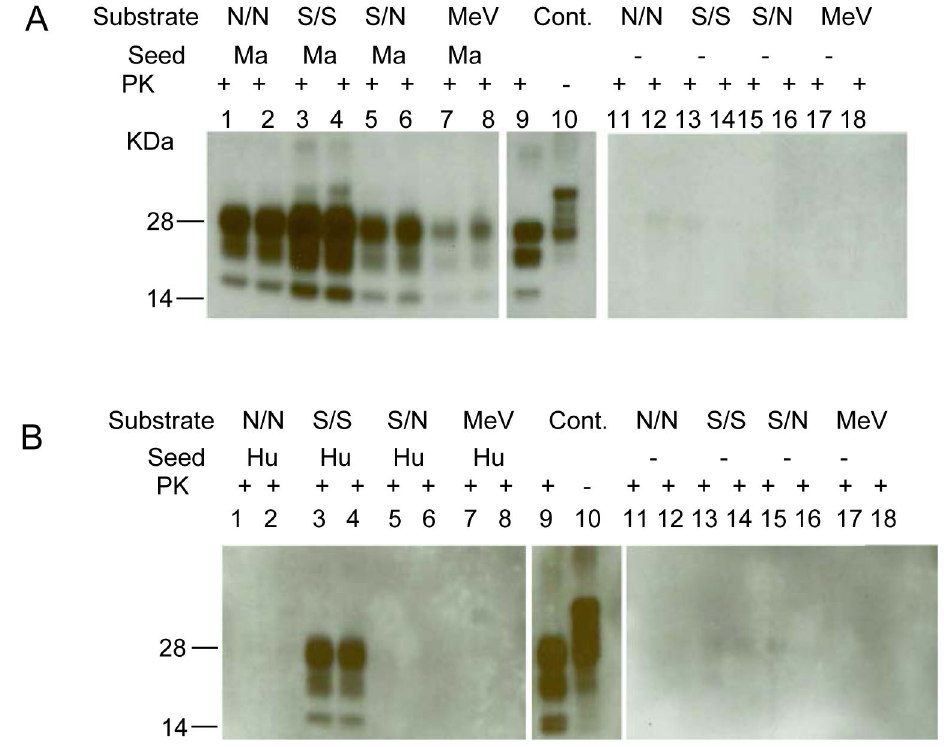
Figure 3. PMCA is affected by the red-backed vole PrP 170 polymorphism. (A) Brain material from macaques clinically ill with vCJD was diluted 10 -3 into 10% RBV 170N/N NBH (lanes 1-2), into 10% RBV 170S/S NBH (lanes 3-4), into 10% RBV 170S/N NBH (lanes 5-6), or into 10% meadow vole (MeV) NBH (lanes 7-8) and subjected to 1 round of PMCA with 3 beads in each. Macaque vCJD brain homogenate (5%) was loaded in lanes 9-10 as positive control (Cont.). Lanes 11-18 indicate 10% RBV 170 (N/N, S/S, S/N respectively), MeV NBH without seed and subjected to 1 round of PMCA. Lanes 1-8 and 11-18 were stained with 6D11 antibody and lanes 9-10 were stained with 3F4 antibody. Prior to electrophoresis, samples were digested with PK. (B) Human vCJD brain material was diluted 10 -3 into 10% RBV 170N/N NBH (lanes 1-2), into 10% RBV 170S/S NBH (lanes 3-4), into 10% RBV 170S/N NBH (lanes 5-6), into 10% meadow vole NBH (lanes 7-8) and subjected to 1 round of PMCA with 3 beads in each. Human vCJD brain homogenate (5%) was loaded in lanes 9-10 as positive control (Cont.). Lanes 11-18 indicate 10% RBV 170 (N/N, S/S, S/N), MeV NBH without seed and subjected to 1 round of PMCA. Prior to electrophoresis, samples were digested with PK. Lanes 1-8 and 11-18 were stained with 6D11 antibody and lanes 9-10 were stained with 3F4 antibody. doi: